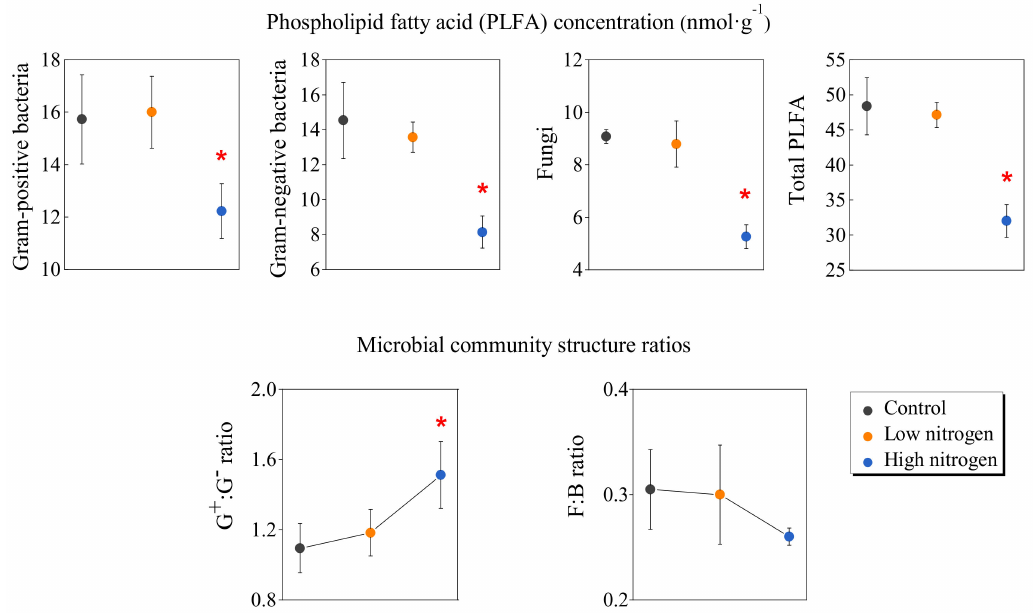
Figure 3. Phospholipid fatty acid (PLFA) concentrations and microbial community structure ratios under di ff erent N addition treatments. Error bars represent standard deviation ( n = 4). * indicates significant di ff erence between the treatment and control at p <